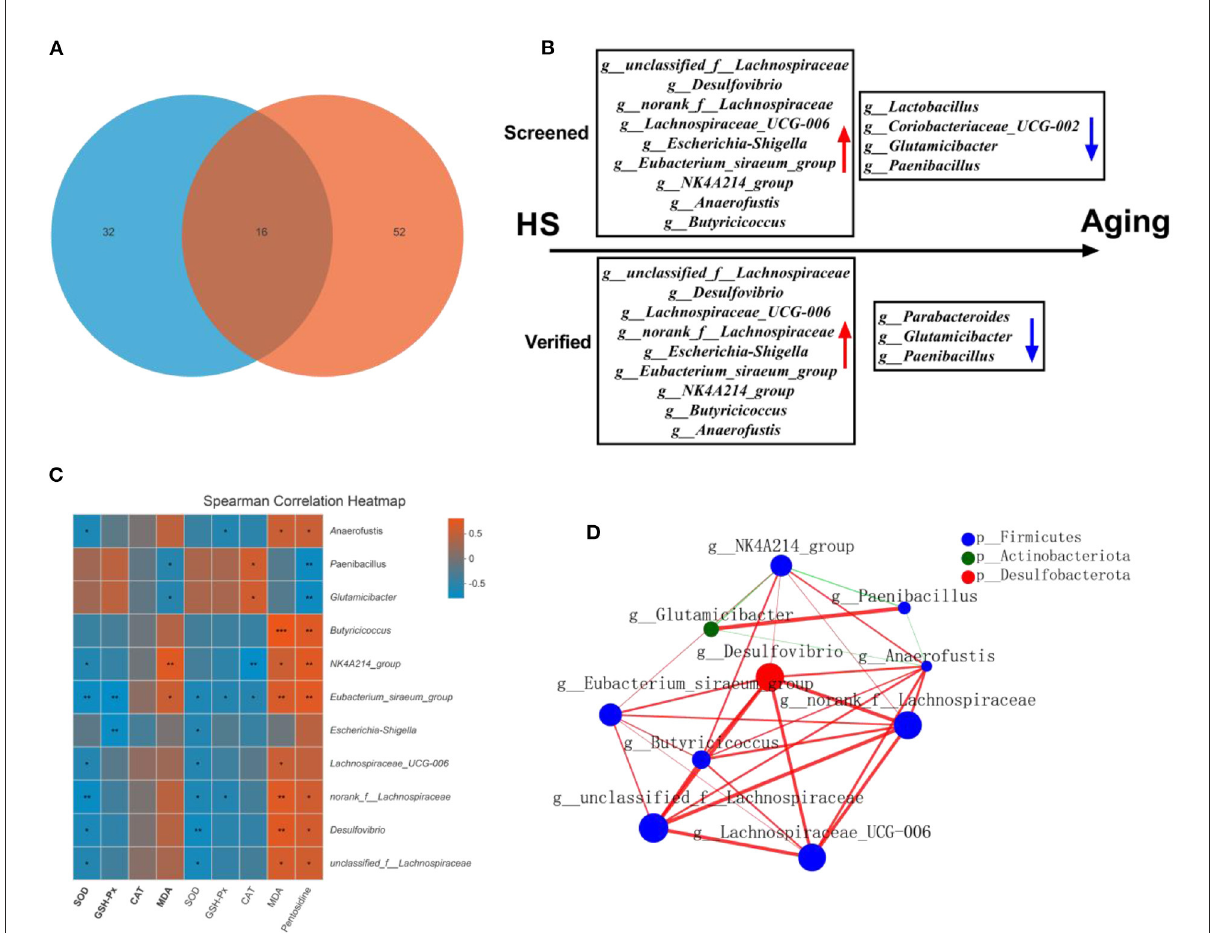
FIGURE7 High salt (HS) significantly induced intestinal aging-related factors imbalance, in which key genera were screened by fecal microbiota transplantation and verified in older mice ( n = 6). The common genra are shown in here (A) . The screened and verified gut microbiota in the process of HS induced intestinal aging (B) . The correlation between significantly different 11 in community abundance in terms of genera and intestinal aging-related factors (C) . The network of the significantly different genera (D) . * p < 0.05, ** p < 0.01, *** p <